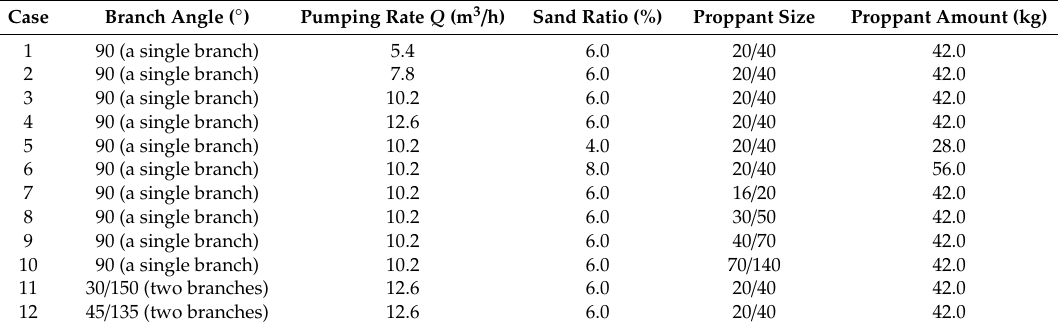
Table 2. Experimental scheme of proppant transport in the complex fracture system.